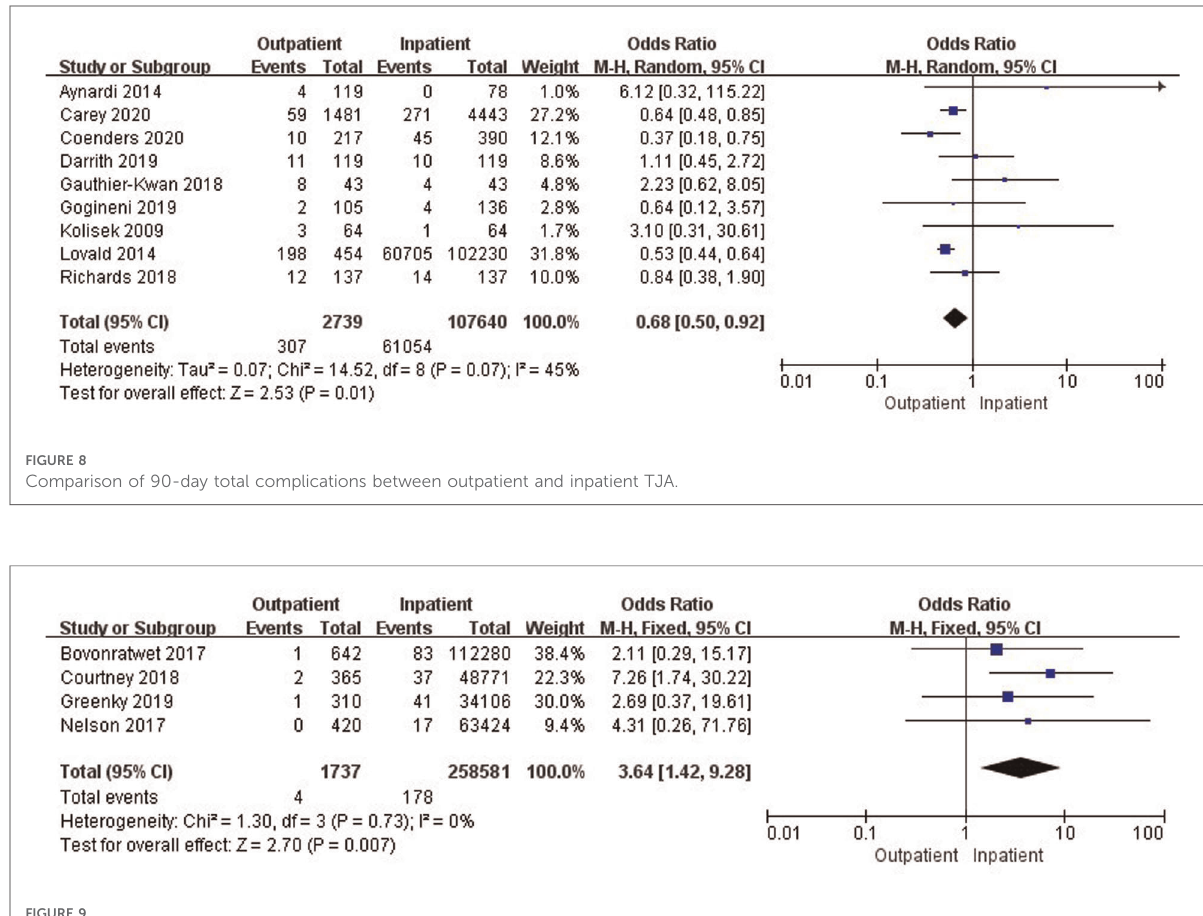
FIGURE 9 Comparison of 30-day cardiac arrests between outpatient and inpatient TJA.